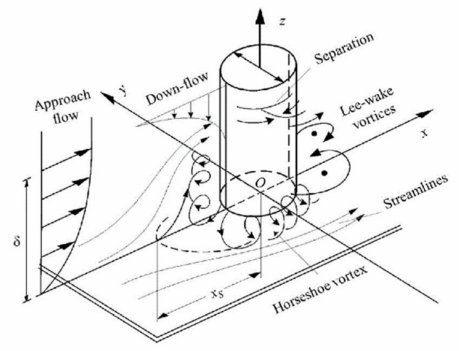
Figure 1. Schematic diagram of water flow and scour around the single